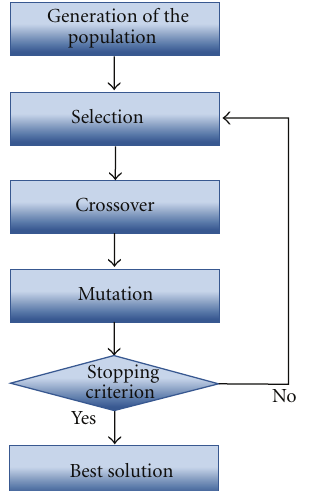
Figure 2: A simplified model of a genetic algorithm.